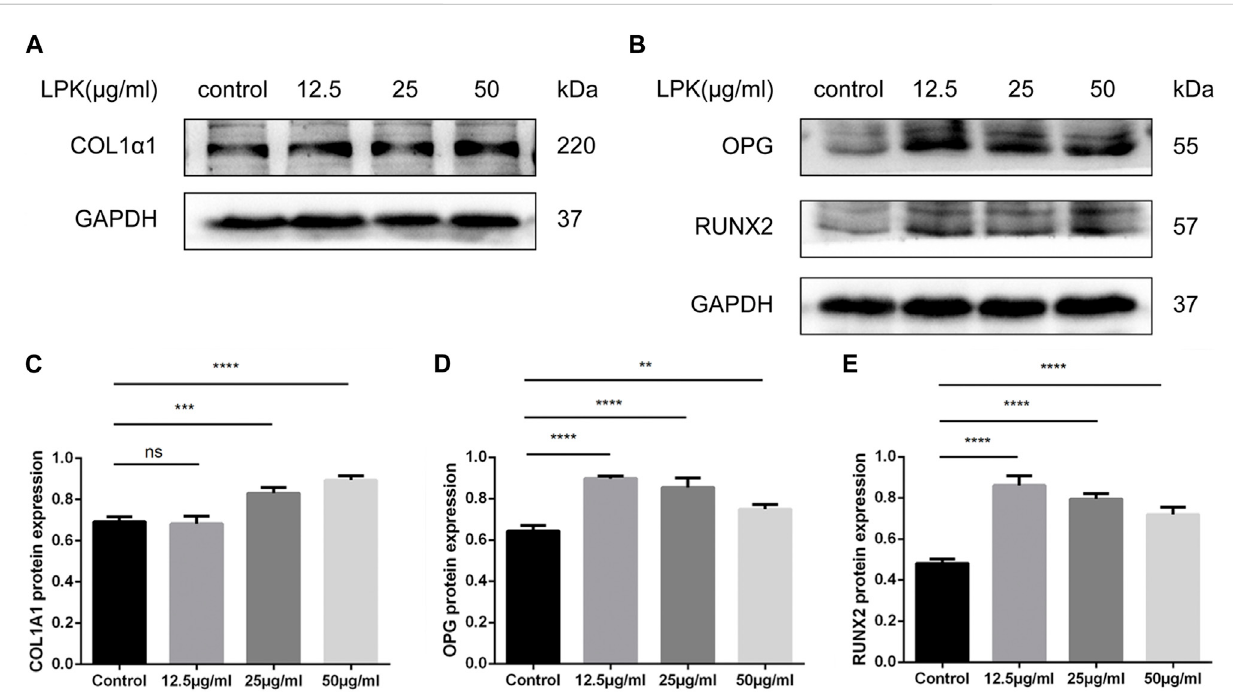
FIGURE 6 Western blot results of osteogenic markers of LPK-treated C3H10 cells. (A) Expression levels of type I collagen (COL1A1) in C3H10 cells. (B) Expression levels of osteoprotegerin (OPG) and osteogenic speci fi c transcription factor (RUNX2) in C3H10 cells. (C – E) Comparative analysis of grey values for relevant protein bands, data are shown as mean ± SD ( n = 3). Compared to the control group, differences were considered signi fi cant at p < 0.05 (*); p < 0.005 (**); p < 0.0005 (***); p < 0.00005 (****); ns: the difference was not statistically signi fi